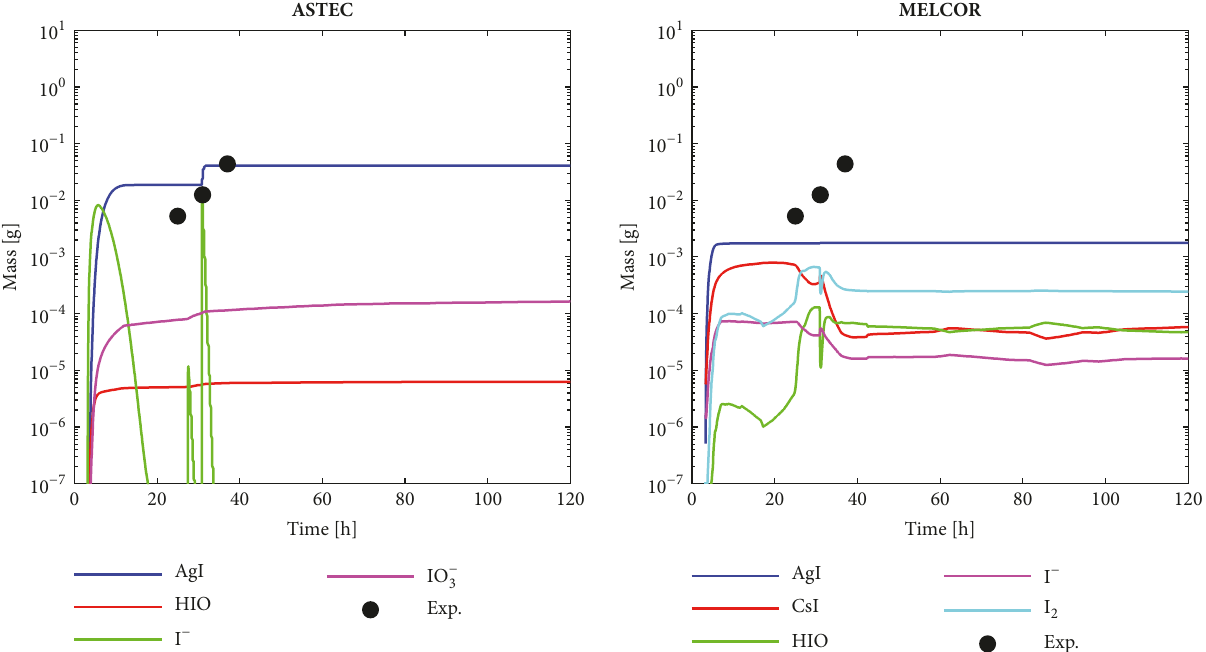
Figure 13: Iodine speciation in the sump water during the Ph´ebus FPT-0 test.